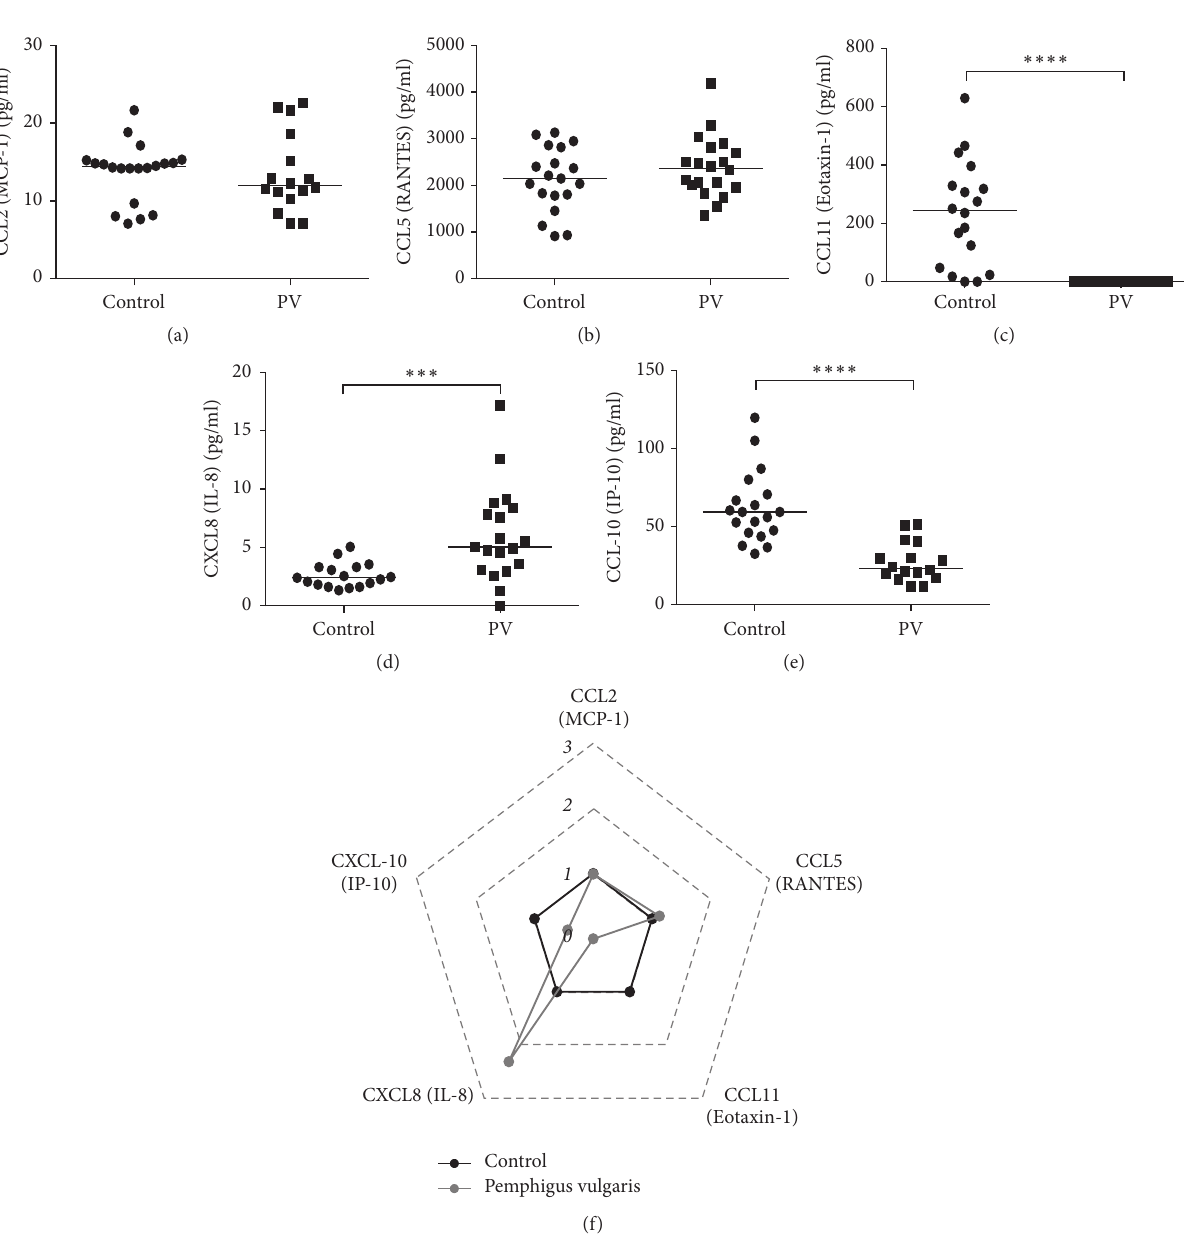
Figure 3: Serum profile of chemokines in Pemphigus vulgaris. Levels of (a) CCL-2/MCP-1, (b) CCL5/RANTES, (c) CCL11/Eotaxin, (d) CXCL8/IL-8, and (e) CCL10/IP-10 in Healthy Donors ( (cid:2) ) and Pemphigus vulgaris patients ( ◼ ). Error bars represent median ± SD. ∗∗∗ 𝑝 < 0.001 ; ∗∗∗∗ 𝑝 < 0.0001 ; Mann–Whitney test. (f) Radar plot representation of serum chemokine pattern. The lines highlight the fold change in cytokine levels in Pemphigus vulgaris patients (gray line) in relation to controls (black line). Data were obtained by calculating the ratio between the median concentration of each cytokine in the Pemphigus vulgaris group and in the control